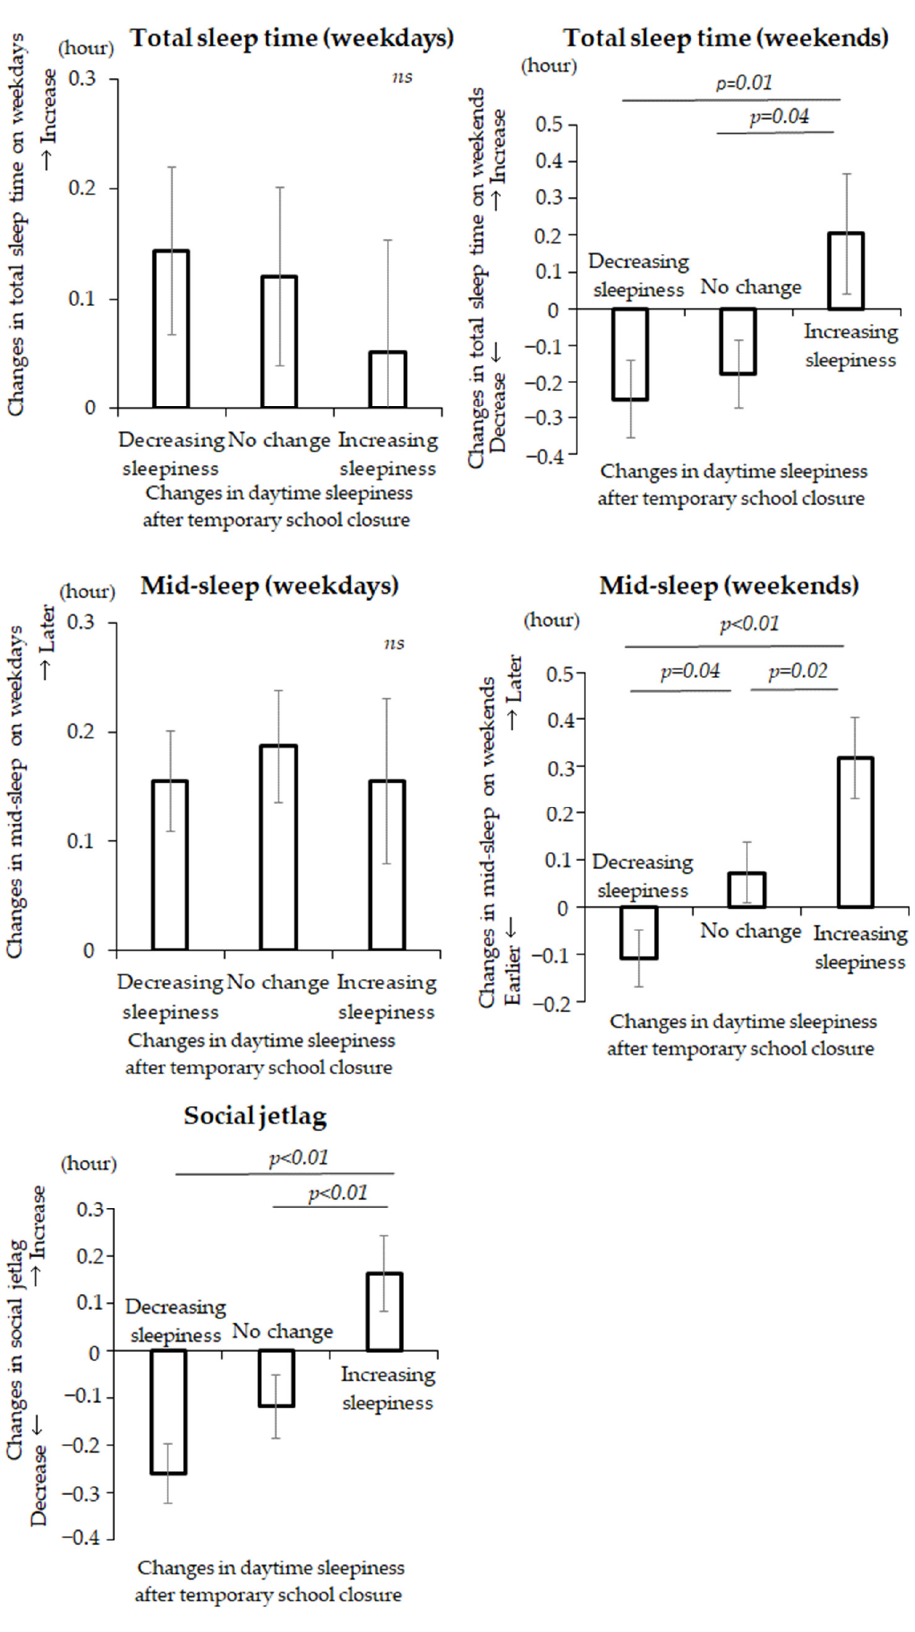
Figure 2. Comparison of changes in sleep variables between three groups categorized by their daytime sleepiness changes (∆PDSS score) from January to June 2020.